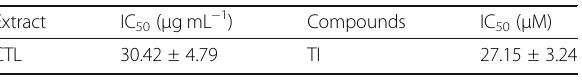
Table 2 EC 50 values of Carpinus tschonoskii leaf (CTL) extract and tellimagrandin I (TI) for effective activity on